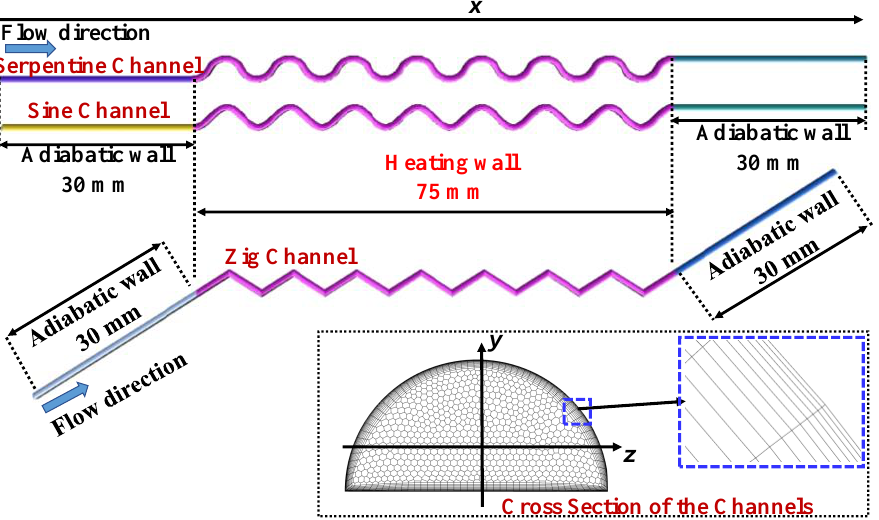
Figure 1. Geometries and meshes.